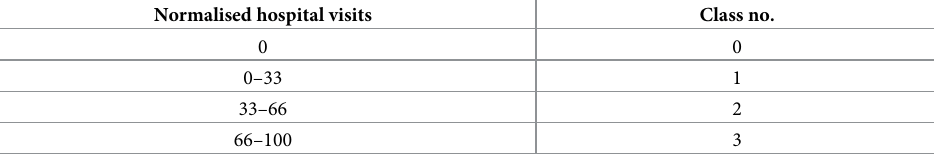
Table 2. Classification of normalised hospital visits used for training the LSTM neural